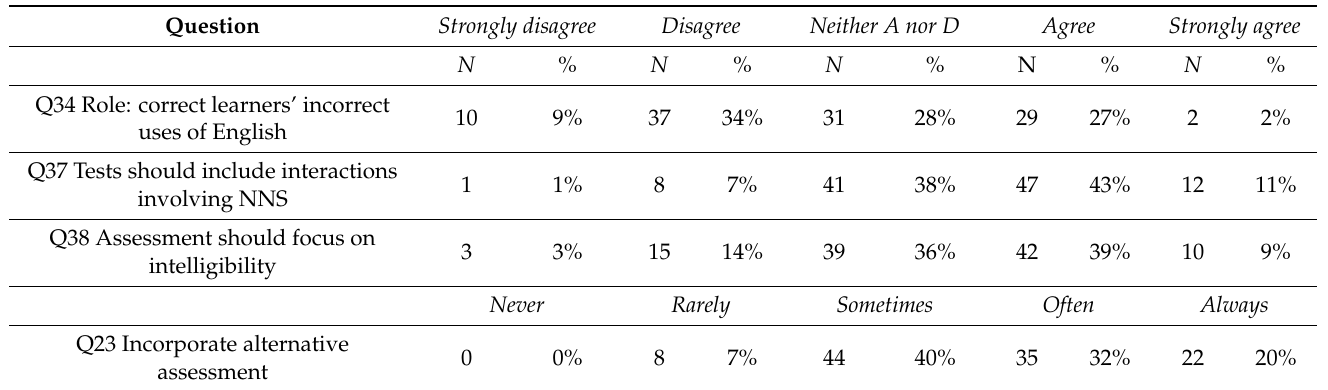
Table 3. Teacher beliefs and practices about English use in assessment.